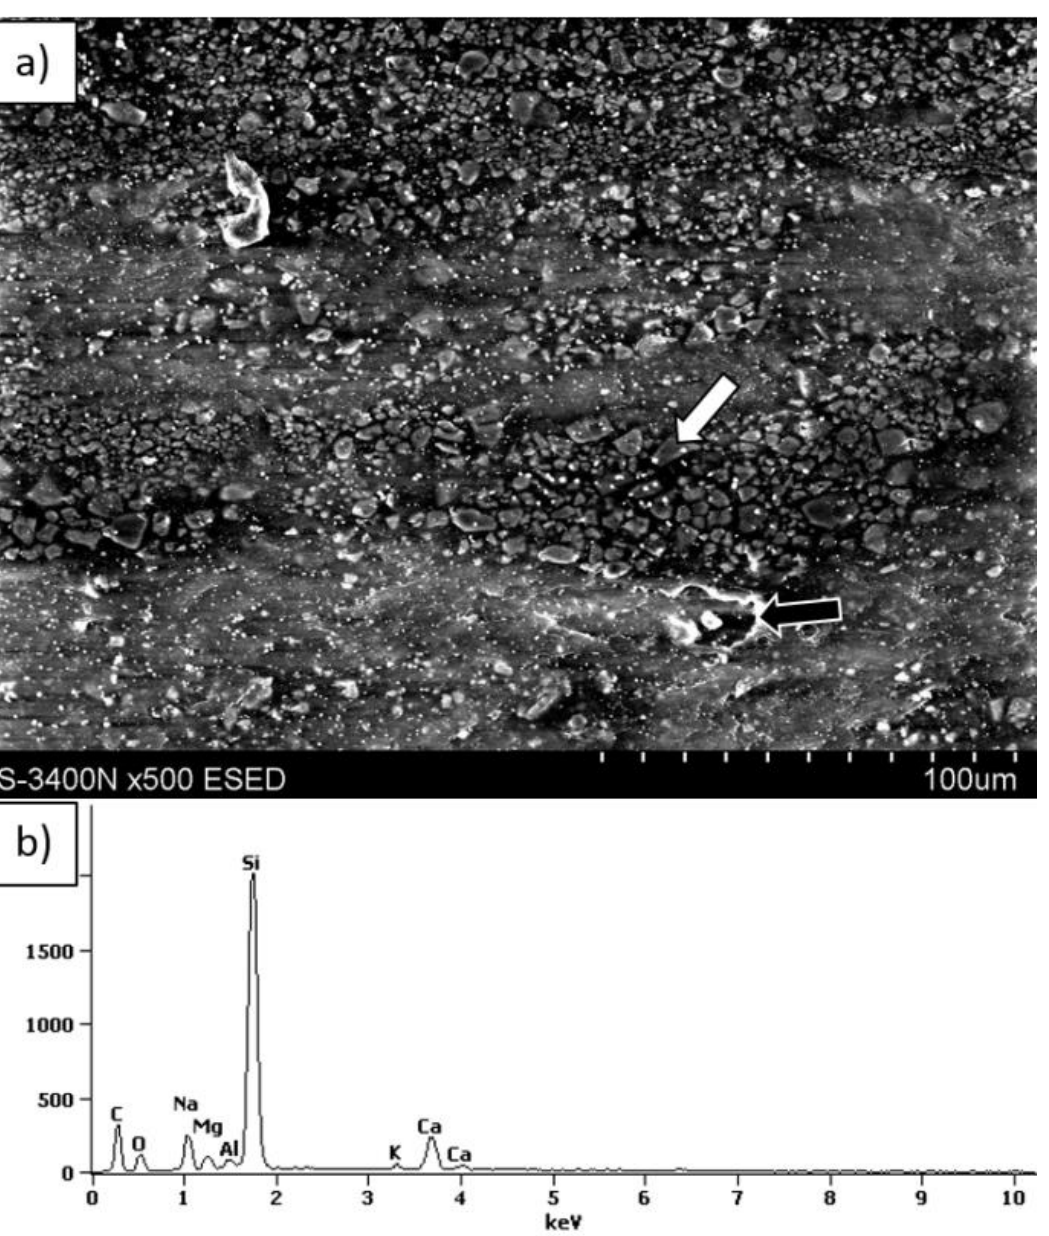
Figure 13. ( a ) Representative SEM micrograph of the LDPE-30% vol. glass composite surface after conducting a friction test with the corresponding energy dispersive spectroscopy (EDS) spectra ( b ) of stacked particles (white arrow). The black arrow indicates a microregion of plastic deformation.